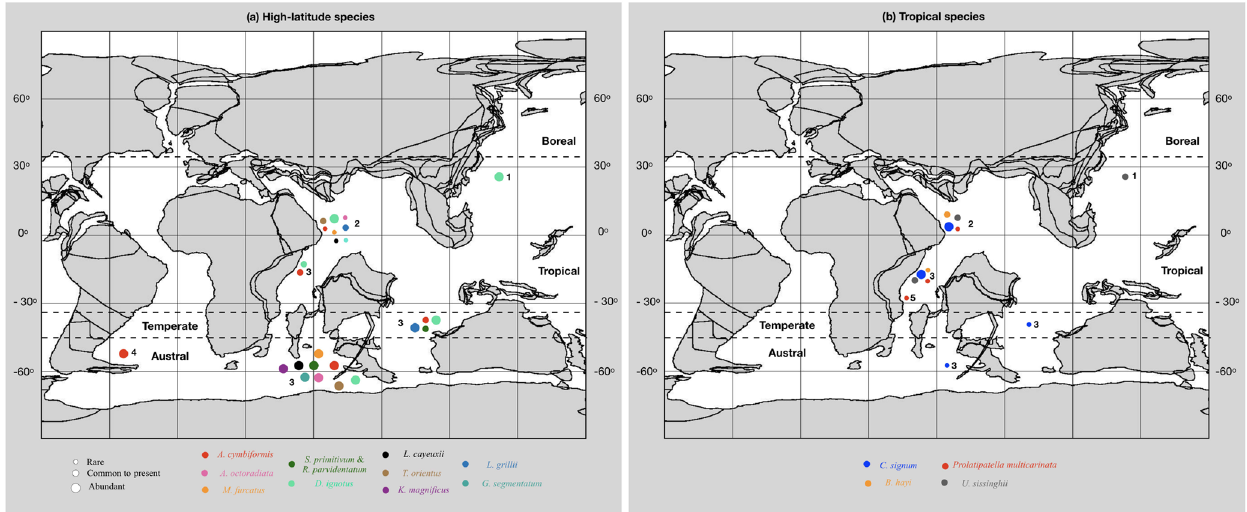
Figure 6. Distribution of selected (a) high-latitude and (b) tropical taxa compared to their status in the study area. Abundance data from (1) Lees and Bown (2005); (2) this study; (3) Lees (2002); (4) Therisin (1981); (5) Lees (2007). Palaeobiogeographic zones from Lees (2002) and Lees and Bown (2005). 75Ma reconstruction map adapted from the PALEOMAP project (http://www.odsn.de/odsn/services/paleomap/ paleomap.html, last access: July